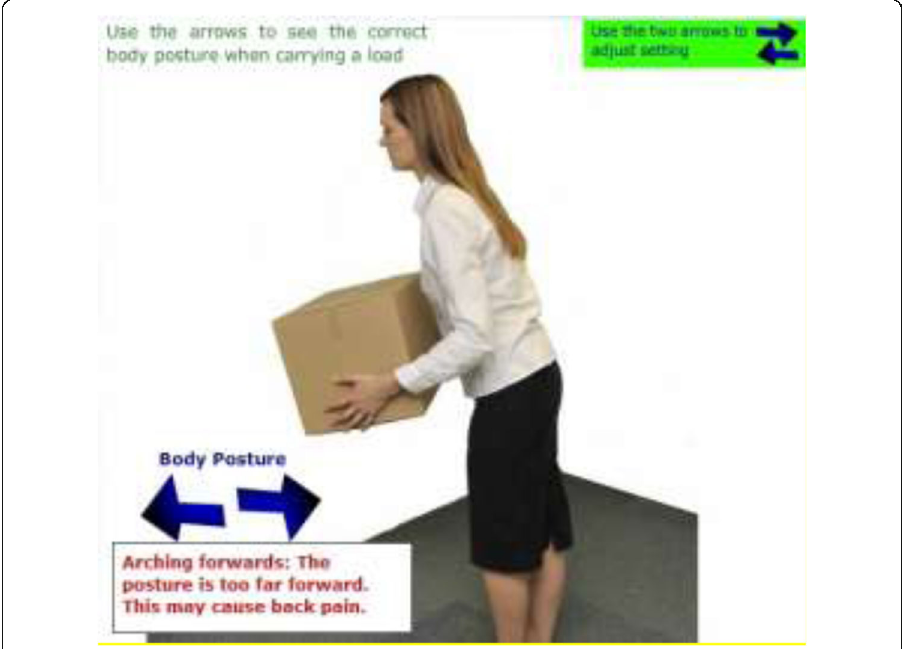
Fig. 2 Using arrows as interactive method to show the right / wrong ways of carrying a load, taken from Manual Handling